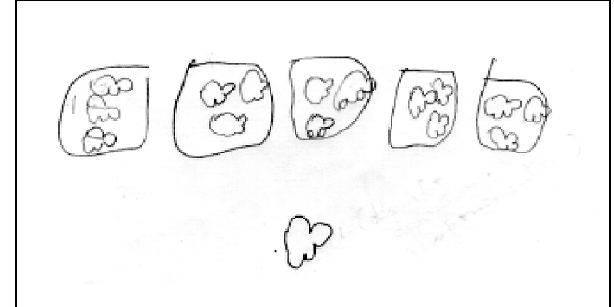
Figura 1. Representa(cid:231)ªo grÆfica do